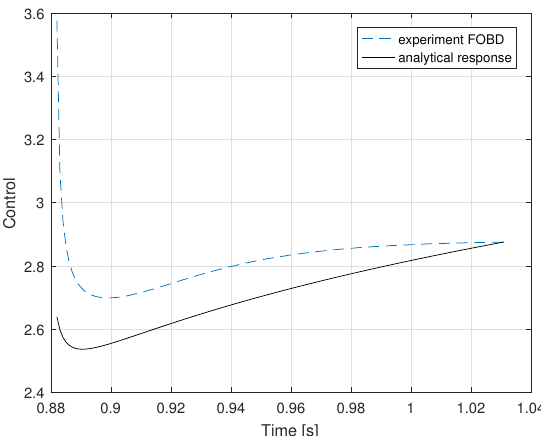
Figure 10. The step response of FOPID using CFE vs. the analytical response, α = 0.25, β = 0.25. IAE = 0.0162, and ISE = 0.0031.